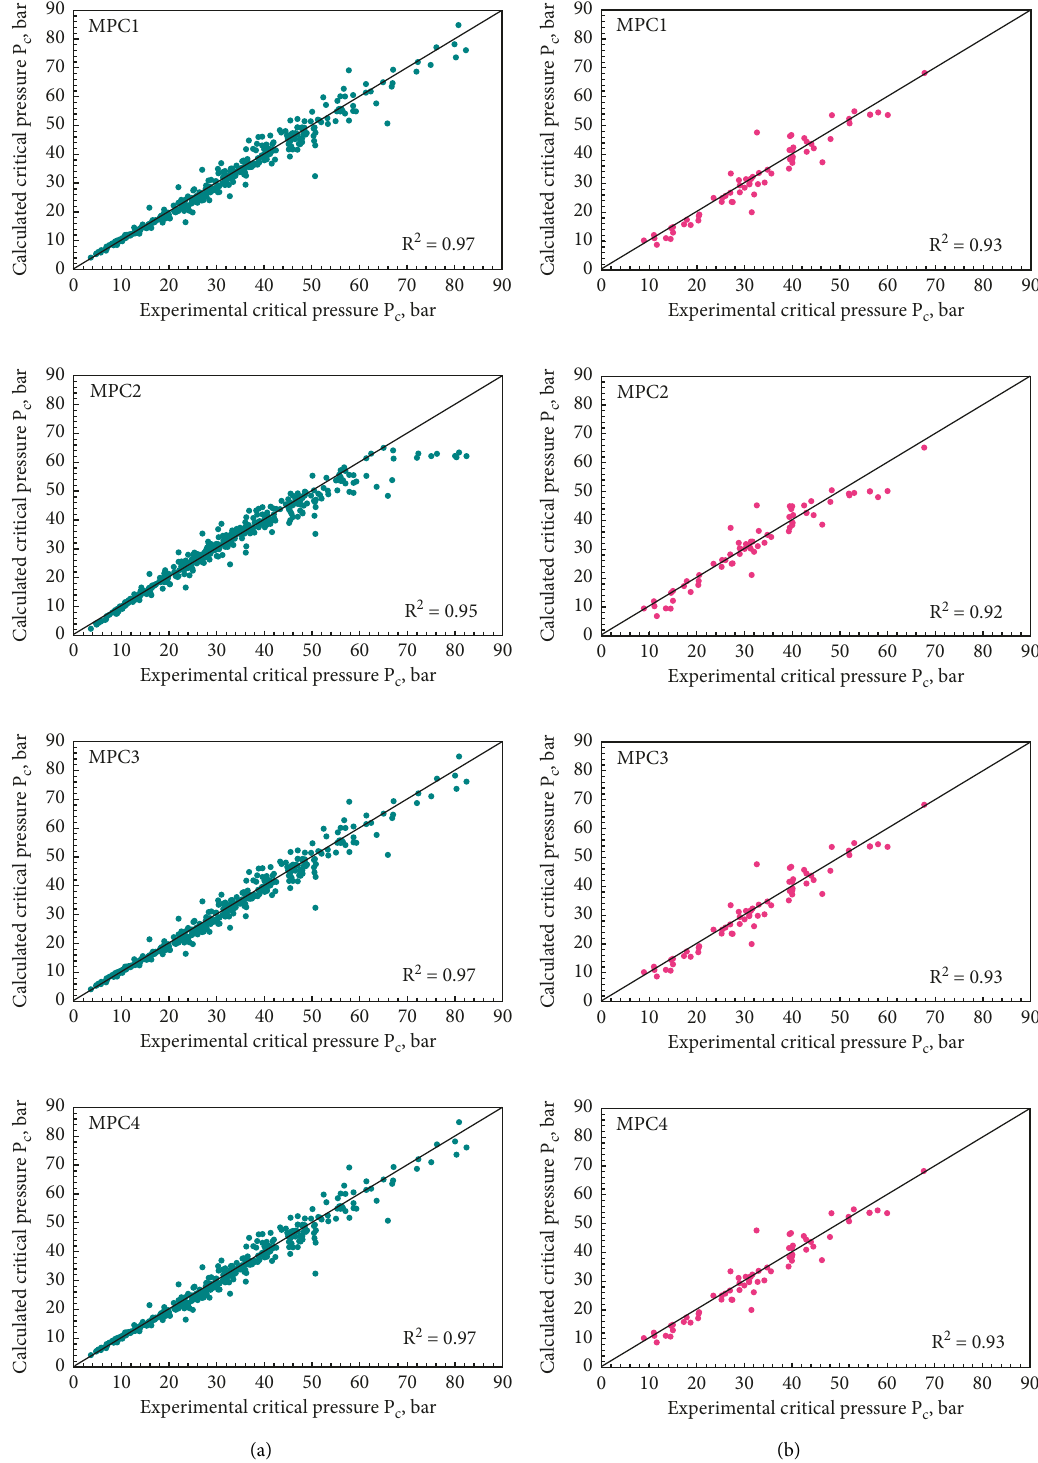
Figure 5: Results of the calculation of critical pressure of pure compounds using different first-order GCMs. (a) Correlation and (b)